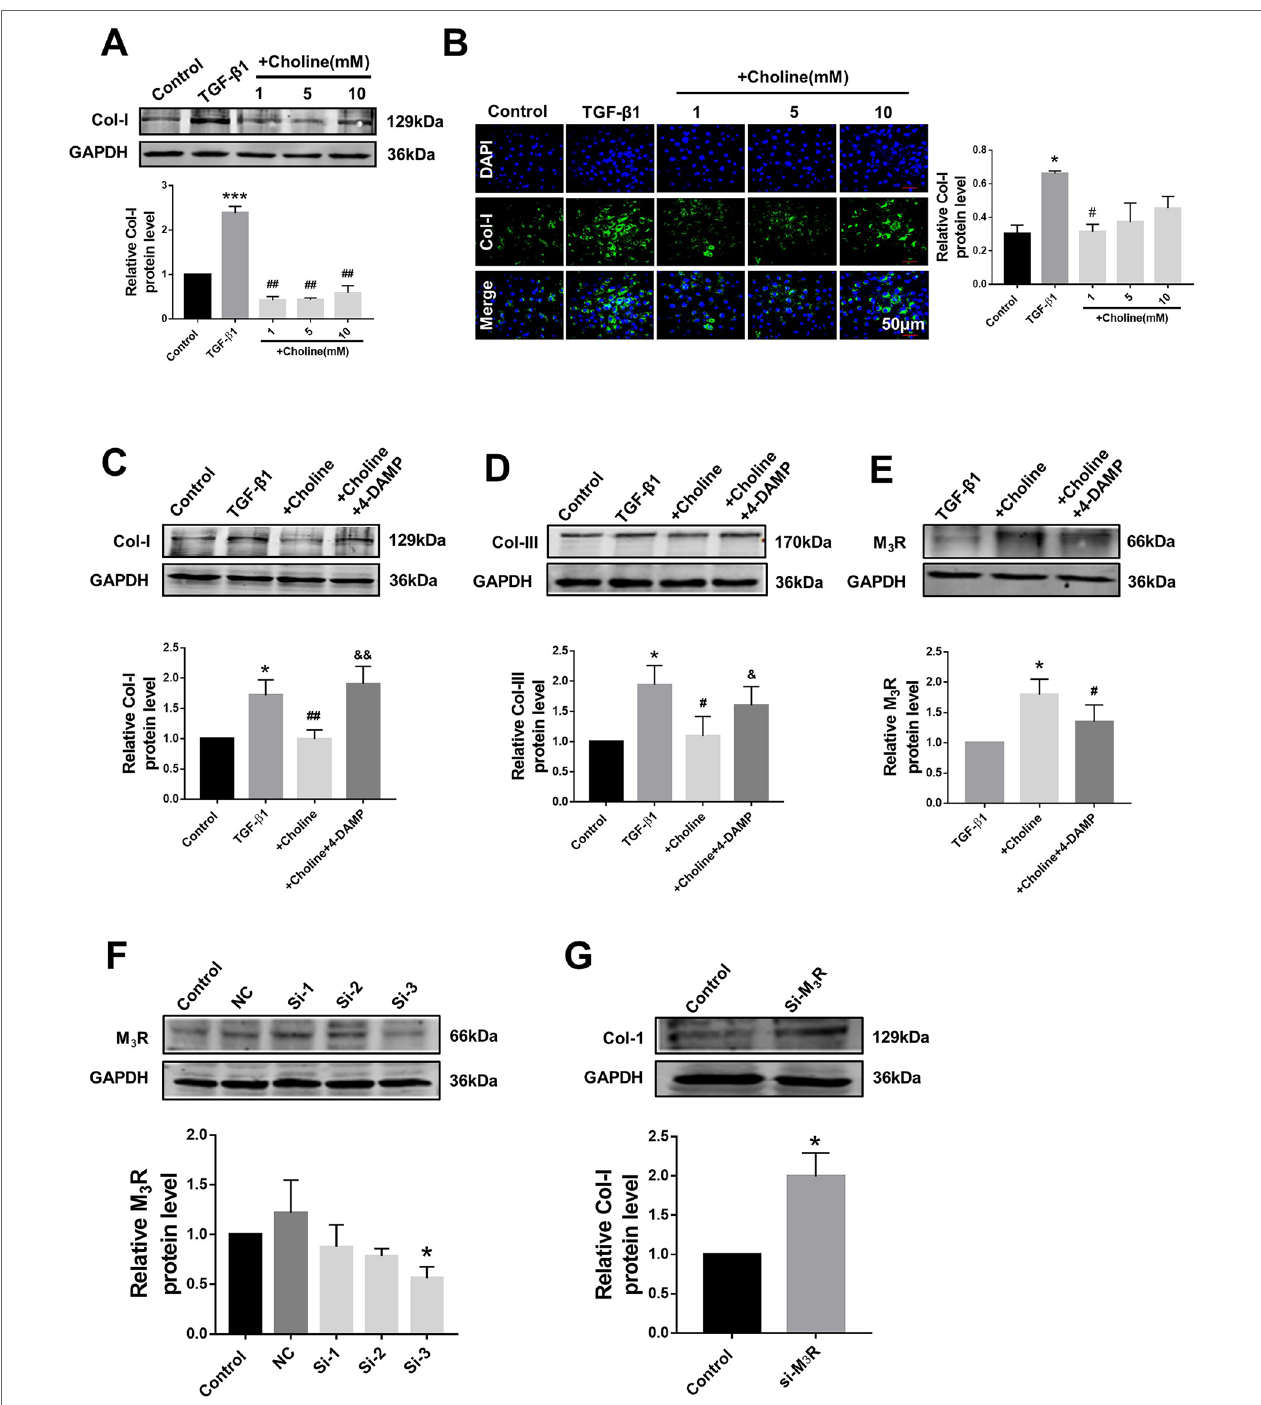
FIgURe 2 | Effects of choline and 4-diphenylacetoxy- N -methylpiperidine methiodide (4-DAMP) on transforming growth factor beta 1 (TGF-β1)-induced collagen secretion. (A) Effects of different concentrations of choline (1, 5, 10 mM) on protein level of collagen I. *** p < 0.001 vs. Ctrl, ## p < 0.01 vs. TGF-β1, n = 5. (B) Immunofluorescence for collagen I in cardiac fibroblasts (CF). Images were obtained using fluorescence microscopy. Blue fluorescence indicates 4′,6-diamidino- 2-phenylindole, green fluorescence indicates collagen I, scale bars: 50 μm. * p < 0.05 vs. Ctrl, # p < 0.05 vs. TGF-β1, n = 3. (C) Effect of choline on collagen I protein level in the different experimental groups. * p < 0.05 vs. Ctrl, ## p < 0.01 vs. TGF-β1, && p < 0.01 vs. choline, n = 7. (D) Effect of choline on collagen III protein level in the different experimental groups. * p < 0.05 vs. Ctrl, # p < 0.05 vs. TGF-β1, & p < 0.05 vs. choline, n = 6. (e) Effects of choline (1 mM) and 4-DAMP (3 nM) on protein level of M 3 muscarinic acetylcholine receptor (M 3 R) in TGF-β1-treated CF. * p < 0.05 vs. Ctrl, # p < 0.05 vs. TGF-β1, n = 5. (F) Protein level of M 3 R after transfecting with three fragments of